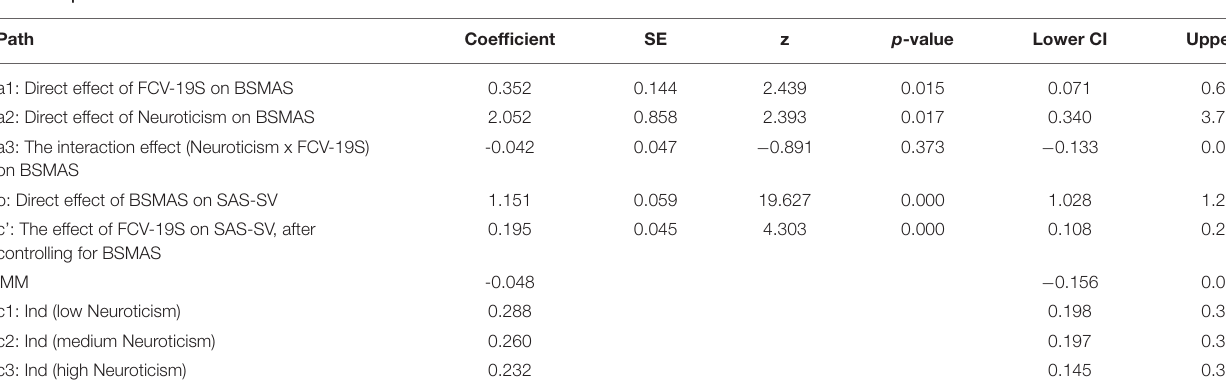
TABLE 4 | Moderated mediation model